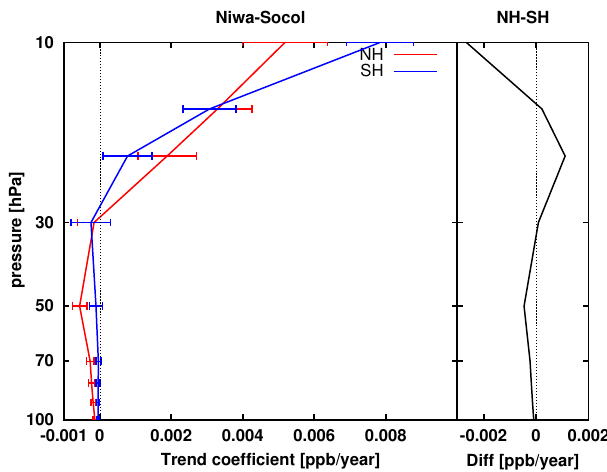
Fig. 13. Trend coefficients from NIWA-SOCOL of NO x averaged over 45 to 60 ◦ N (red) and 45 to 60 ◦ S (blue) as a function of height. The error bars are the one σ uncertainties in the fit coefficients. The right panel shows the NH − SH